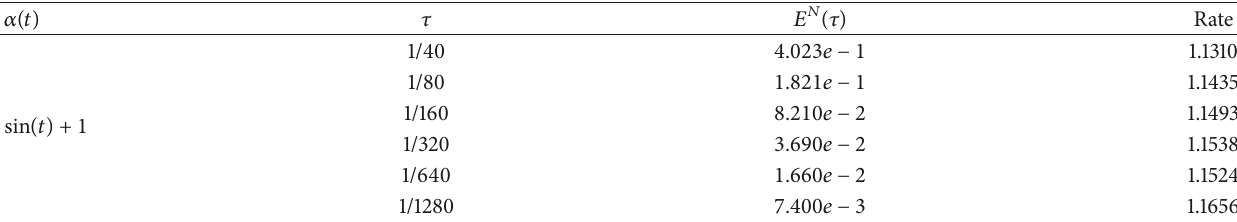
Table 7: Maximum errors and convergence rates for Example 2 at 𝑇 = 1 and 𝜎 = 3/2 − 𝛼 1 /2 . 𝛼(𝑡) 𝜏 𝐸 𝑁 (𝜏)